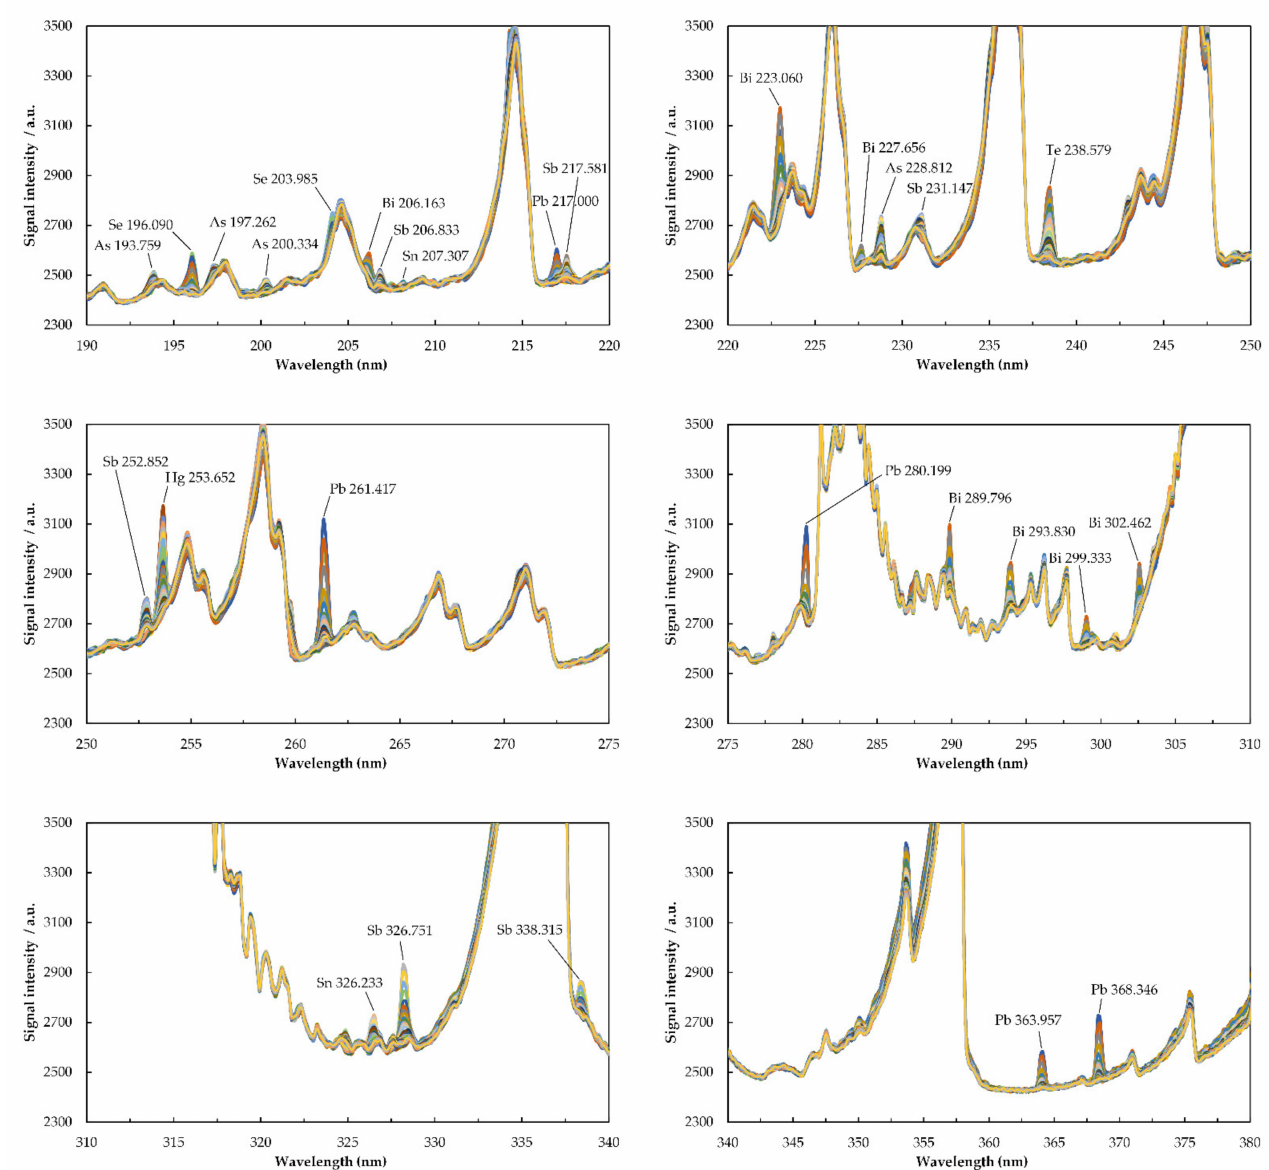
Figure 2. Episodic emission spectra of As, Bi, Sb, Se, Te, Hg, Pb, and Sn in SSETV- µ CCP-OES recorded with the Ocean Optics QE65 Pro microspectrometer in High-Speed Acquisition mode. Conditions: 10 µ L sample volume containing 3 µ g mL − 1 As, Bi, Se, Te, and Sn; 1 µ g mL − 1 Pb and Sb; and 0.2 µ g mL − 1 Hg; drying temperature: 80 ◦ C for 180 s; electrothermal vaporization temperature: 1300 ◦ C for 10 s; integration time per episode: 200 ms; plasma power: 15 W; Ar flow rate: 150 mL min − 1 ; observation height: 0.8 mm above the electrode